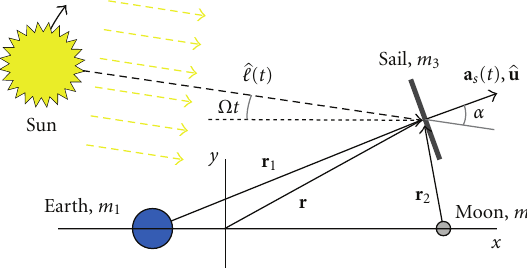
Figure 1: Earth-Moon system